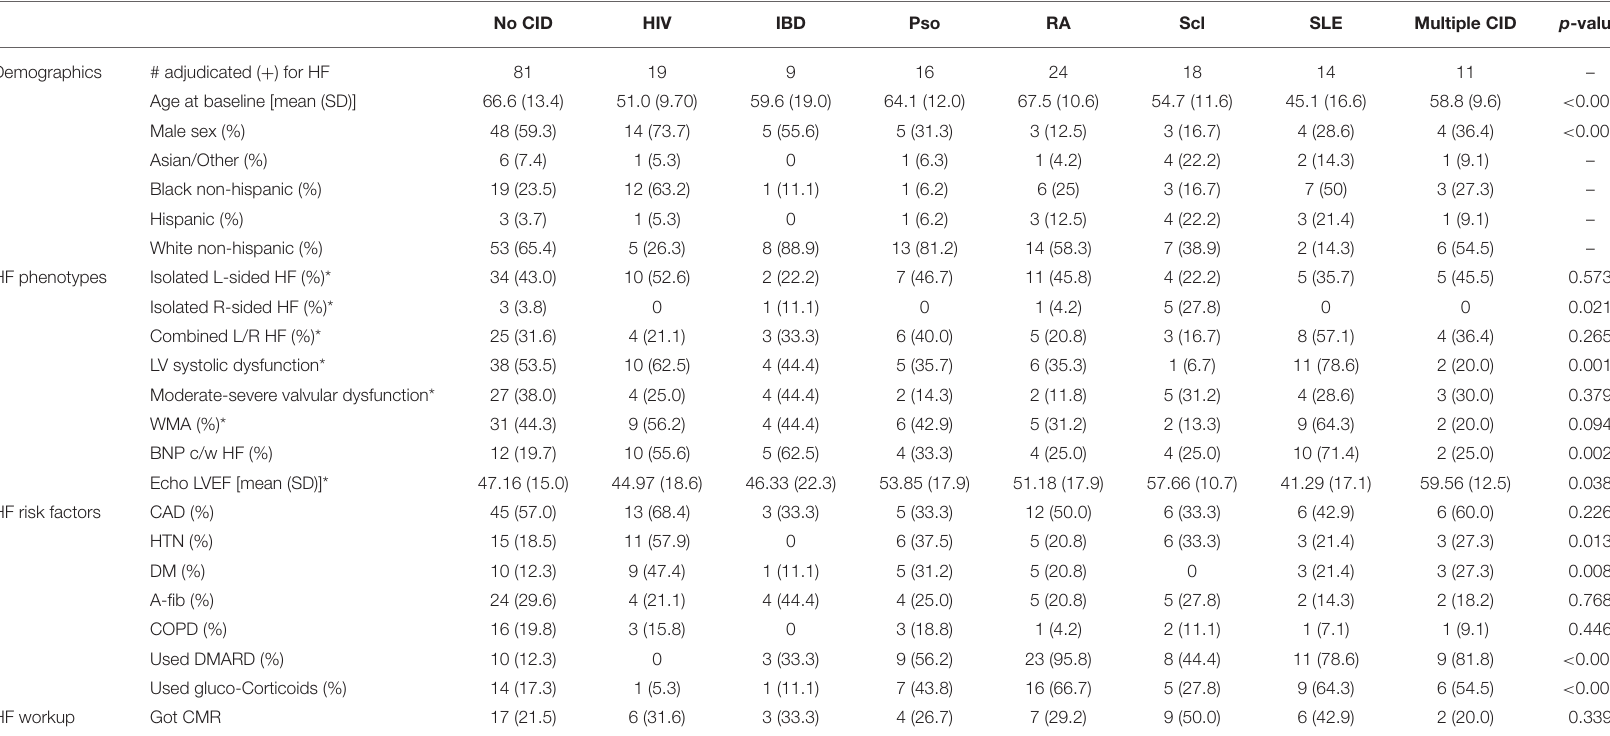
TABLE 1 | Heart failure demographics, phenotypes, risk factors, and workup among patients with and without chronic inflammatory diseases who adjudicated positive for heart failure. No CID HIV IBD Pso RA Scl SLE Multiple CID p